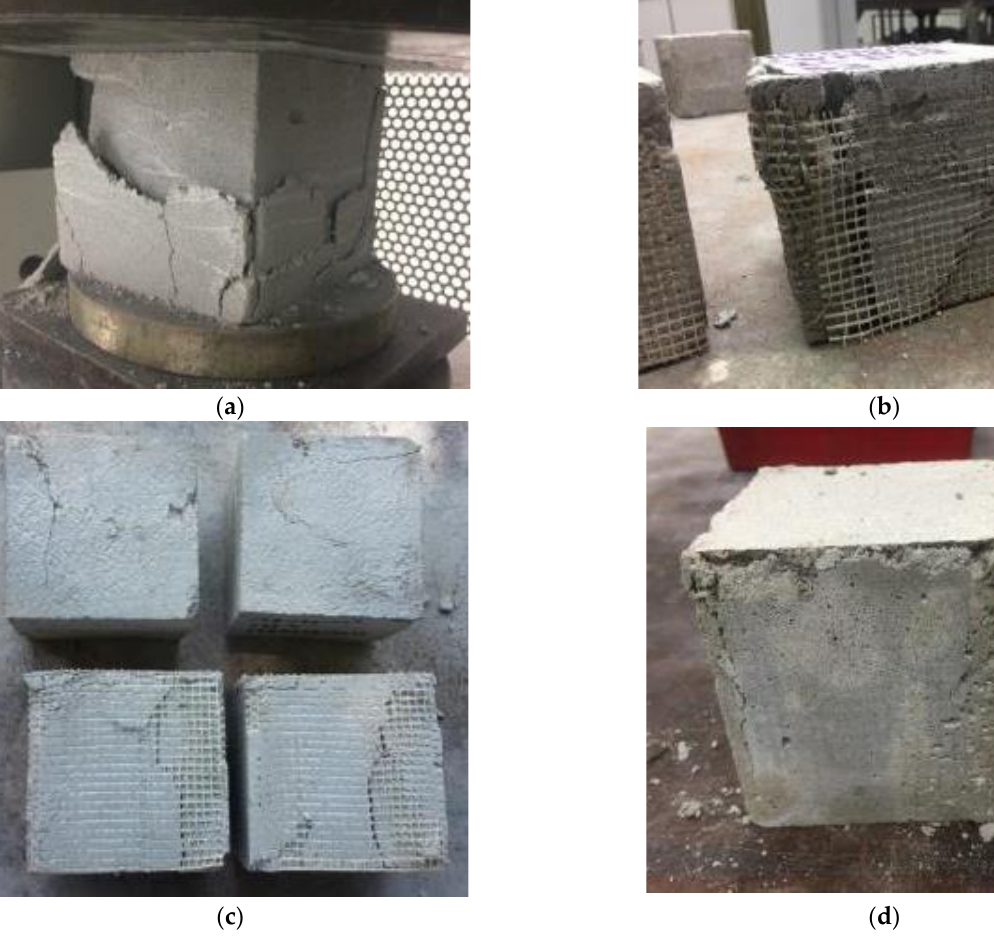
Figure 10. Failure modes of foamcrete under axial loading. ( a ) control specimen ( b ) 1 layer of FM ( c ) 2 layers of FM ( d ) 3 layers of FM.